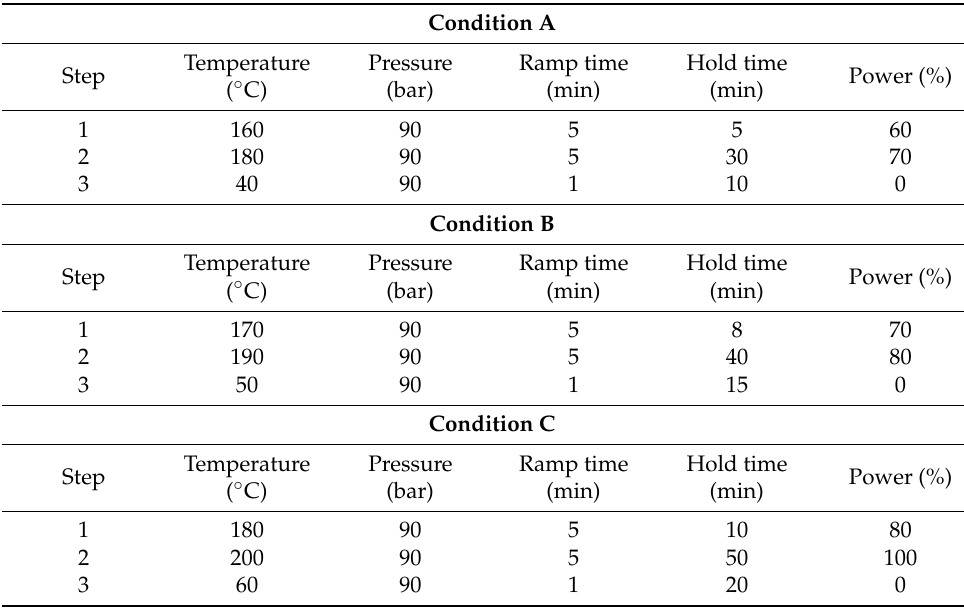
Table 1. Microwave digestion operating conditions.